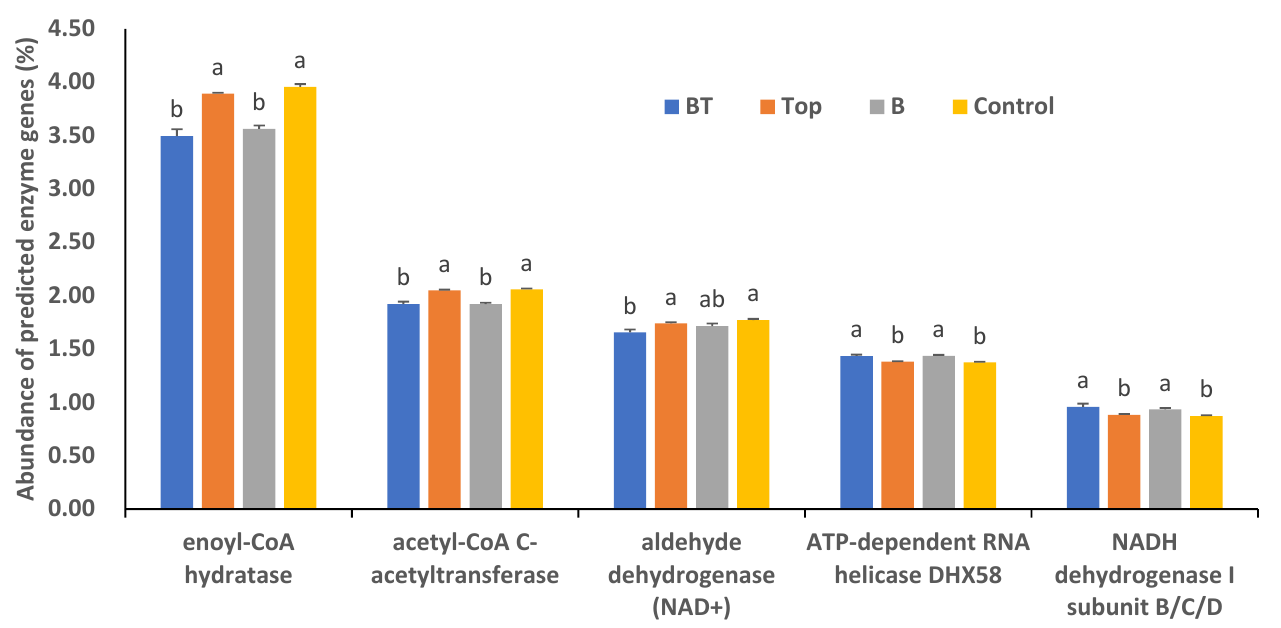
Figure 5. Abundance of several predicted enzyme genes in different treatments and the control. BT, combined base fertilizer and topdressing fertilizer; Top, topdressing fertilizer; Base, base fertilizer; Control, no fertilizer. Different lowercase letters indicate significant differences at p < 0.05.